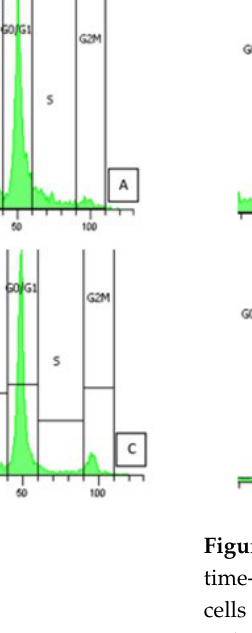
Figure 6. Time dependence of apoptosis rate of exposed PC-3 cell line. Each treatment and control shows the percentage of dead, viable, early apoptosis, and late apoptosis cells. Incubation time for control was the same as treated cell, which were 24 h, 48 h and 72 h. The data represented mean ± standard deviation (SD) of three independent experiments ( n = 3). Statistical analysis is expressed as ** p < 0.001 and ns is non-significant.